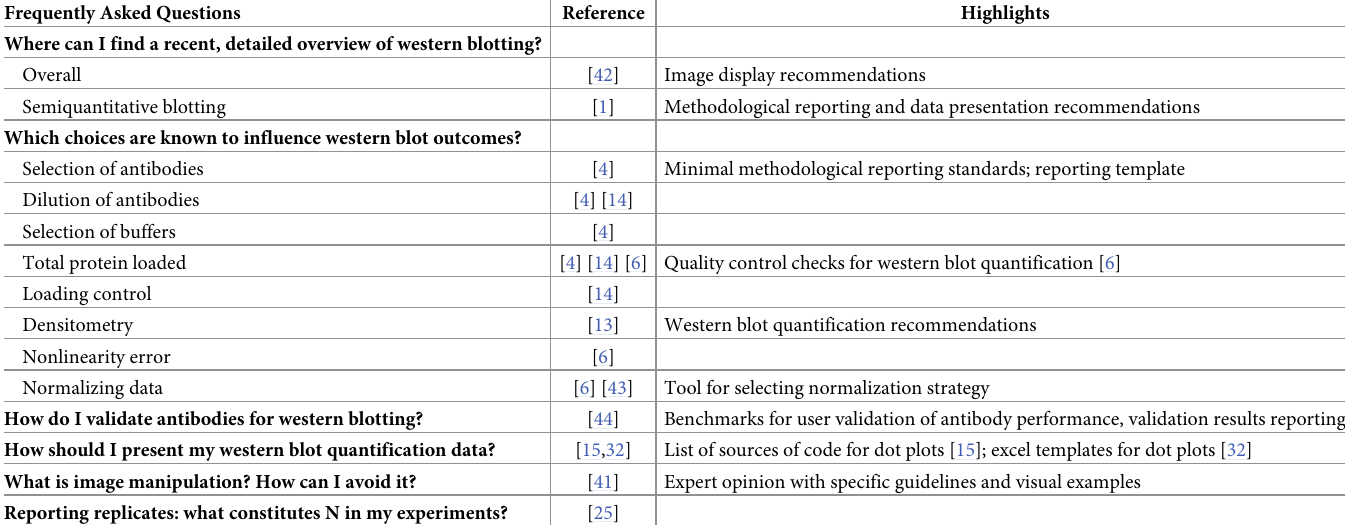
Table 1. Resources to help scientists make western blot experiments more informative and